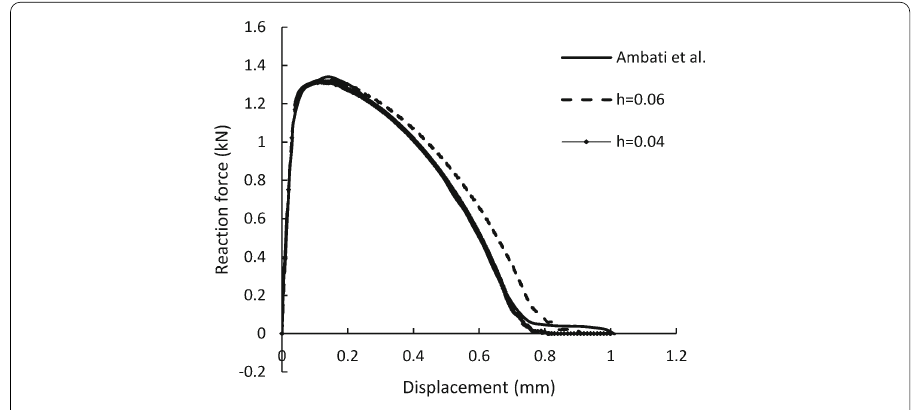
Fig. 11 Mesh sensitivity of the proposed phase field model and comparison with the results in